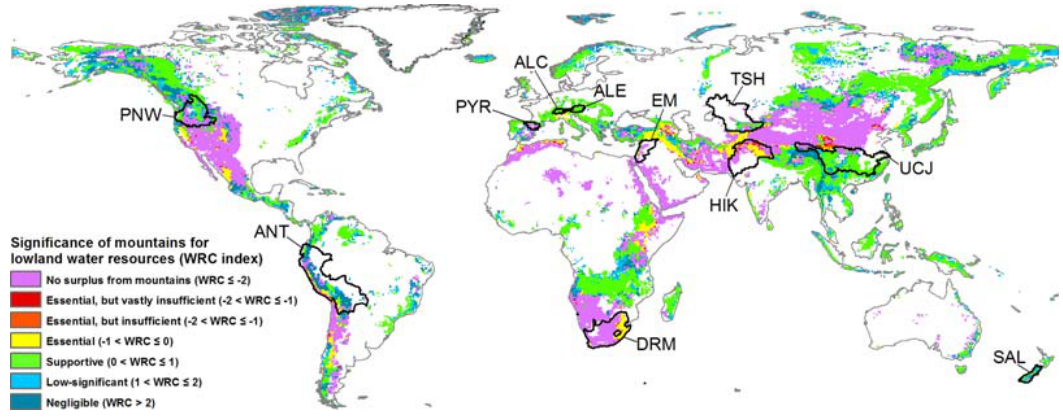
Figure 1. Location of our case-study regions on a world map at a resolution of 0.5° × 0.5° Fig. 1. Location of our case-study regions on a world map at a resolution of 0.5 ◦ × 0.5 ◦ showing the significance of mountain regions for showing the significance of mountain regions for lowland water resources (following Viviroli lowland water resources (following Viviroli et al., et al., 2007).